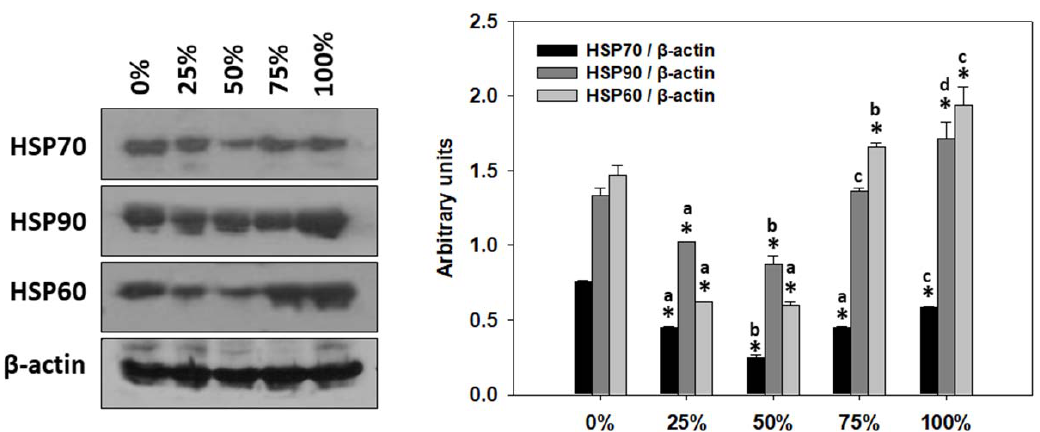
Figure 6. HSP70, HSP90 and HSP60 induction levels (mean ± SD) of Tenebrio molitor larvae reared on substrates containing different content levels of milled carob pods (0, 25, 50, 75 and 100%). Asterisk (*) indicates p < 0.05 compared to 0%, while lower case letters indicate p < 0.05 compared to different carob contents (%).